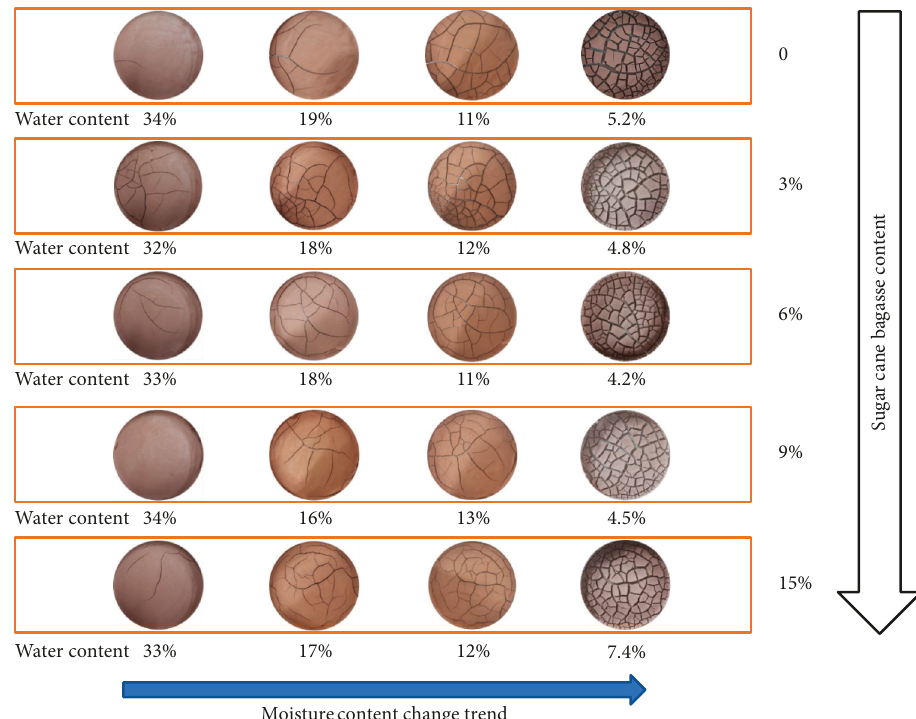
Figure 3: Change image of clay crack network with different bagasse content.